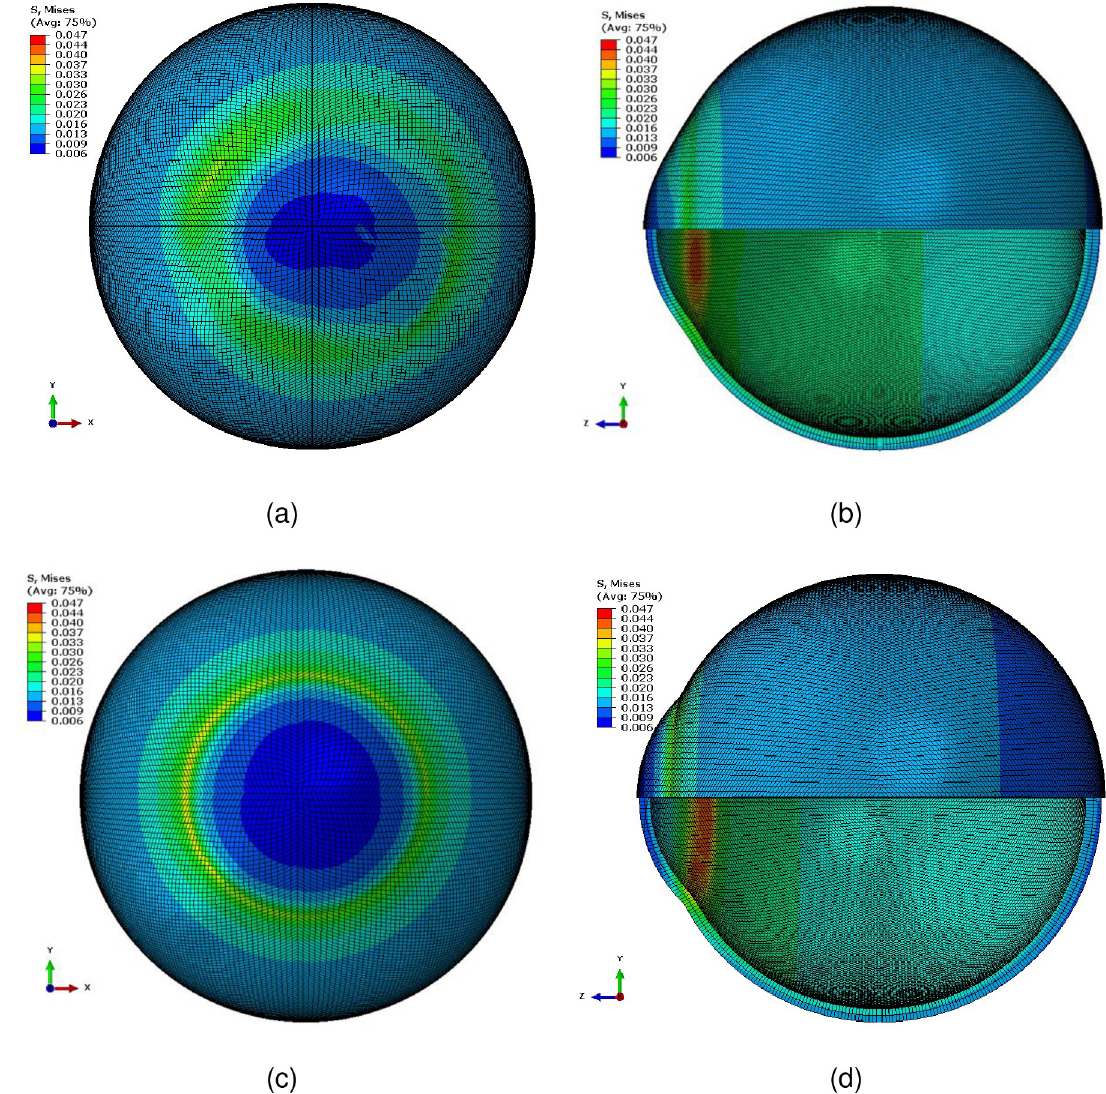
Fig 9. Von Mises stress distribution in MPa of two finite element models for the same subject plotted in Fig 2, (a,b) with the corneal geometry as measured by the ESP, (c,d) with corneal geometry constructed using the paramedic values obtained by fitting the central 5mm radius of the cornea to a conic model with R = 8.3258mm and Q =